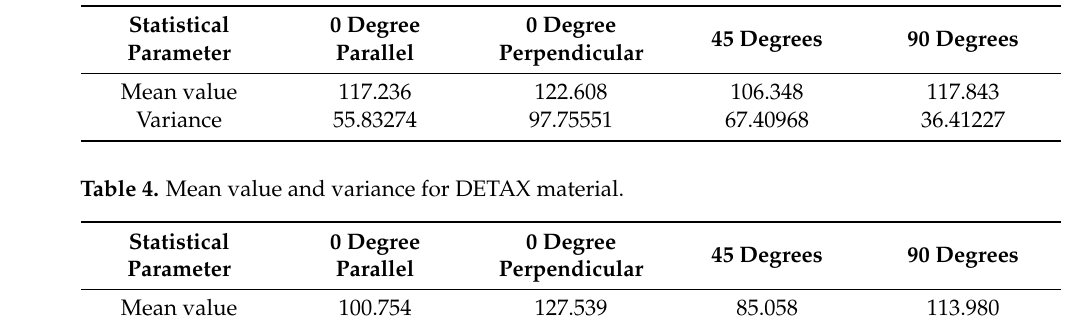
Table 3. Mean value and variance for NEXTDENT material.